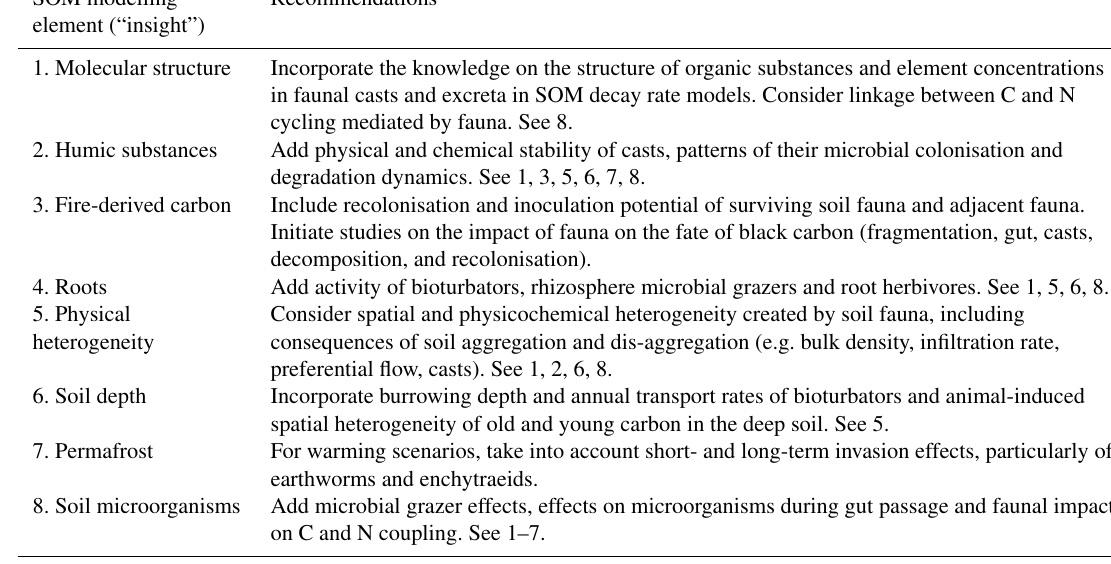
Table 2. “Insights” (compiled after Schmidt et al., 2011) for future soil organic matter models and recommendations for further improvements by implementing effects of soil